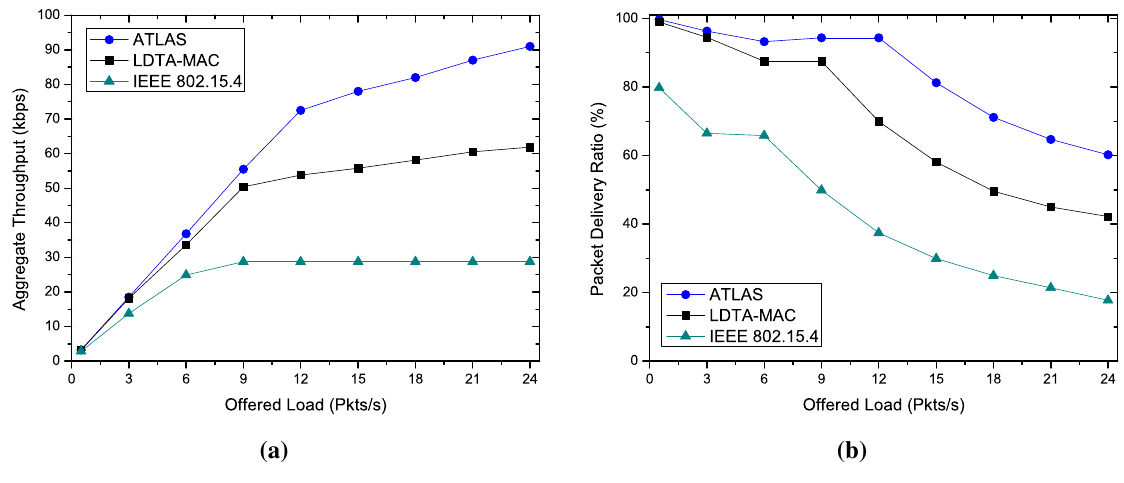
Figure 5. Data fidelity over diverse traffic loads: (a) Aggregate throughput; and (b) Packet delivery